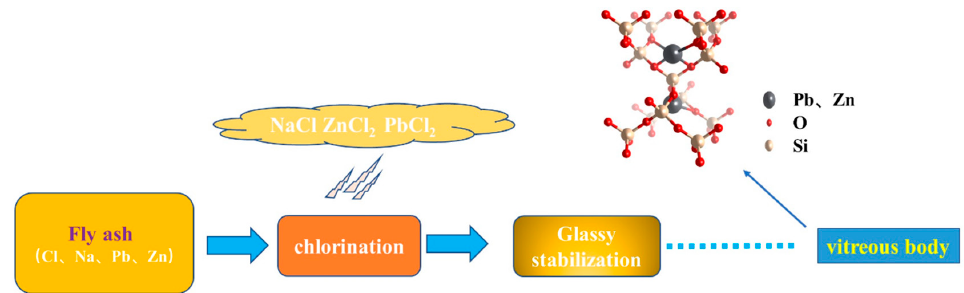
Figure 2. Schematic diagram of the novel process for fly ash disposal.